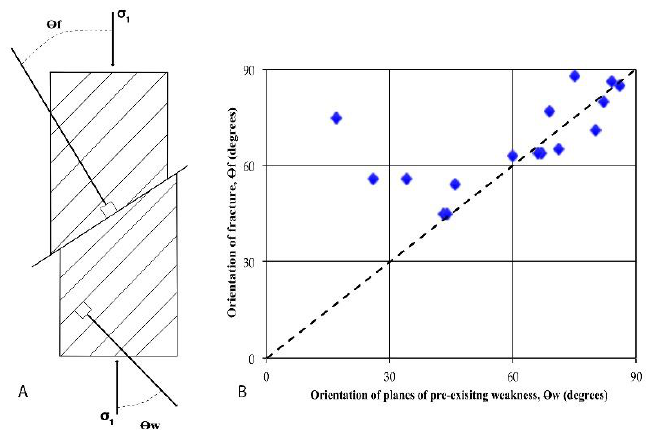
Figure 11. ( A ) Schematic diagram showing the relationship between the orientation of a newly formed fracture and a plane of a pre-existing weakness. ( B ) Plot showing that for samples with pre-existing planes of weakness that make an angle >45 ◦ to the loading direction, failure occurs along the pre-existing planes of weakness. For samples with pre-existing planes of weakness that make an angle <45 ◦ to the loading direction, failure occurs along newly formed shear